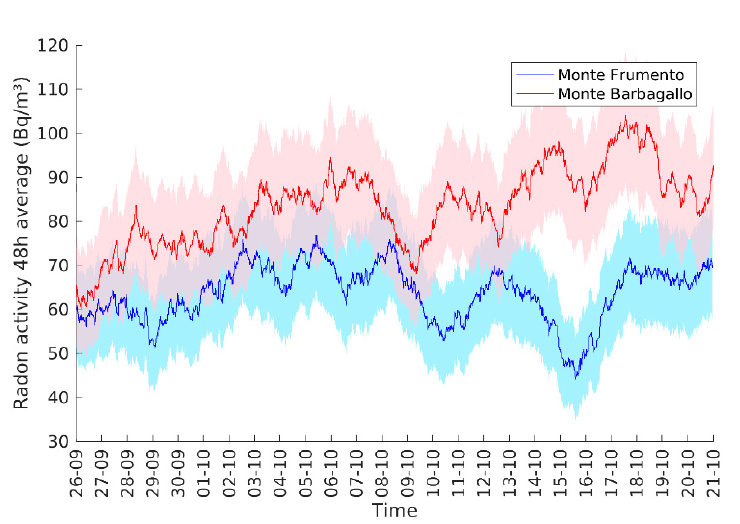
Figure 9. Running a 48-h average of radon activity measured at the Mt. Barbagallo and Mt. Frumento Supino Stations on the Mt. Etna South flank. Colored zones corresponds to a 2-sigma uncertainty in the 48-h mean (computed under the Poisson statistics hypothesis).